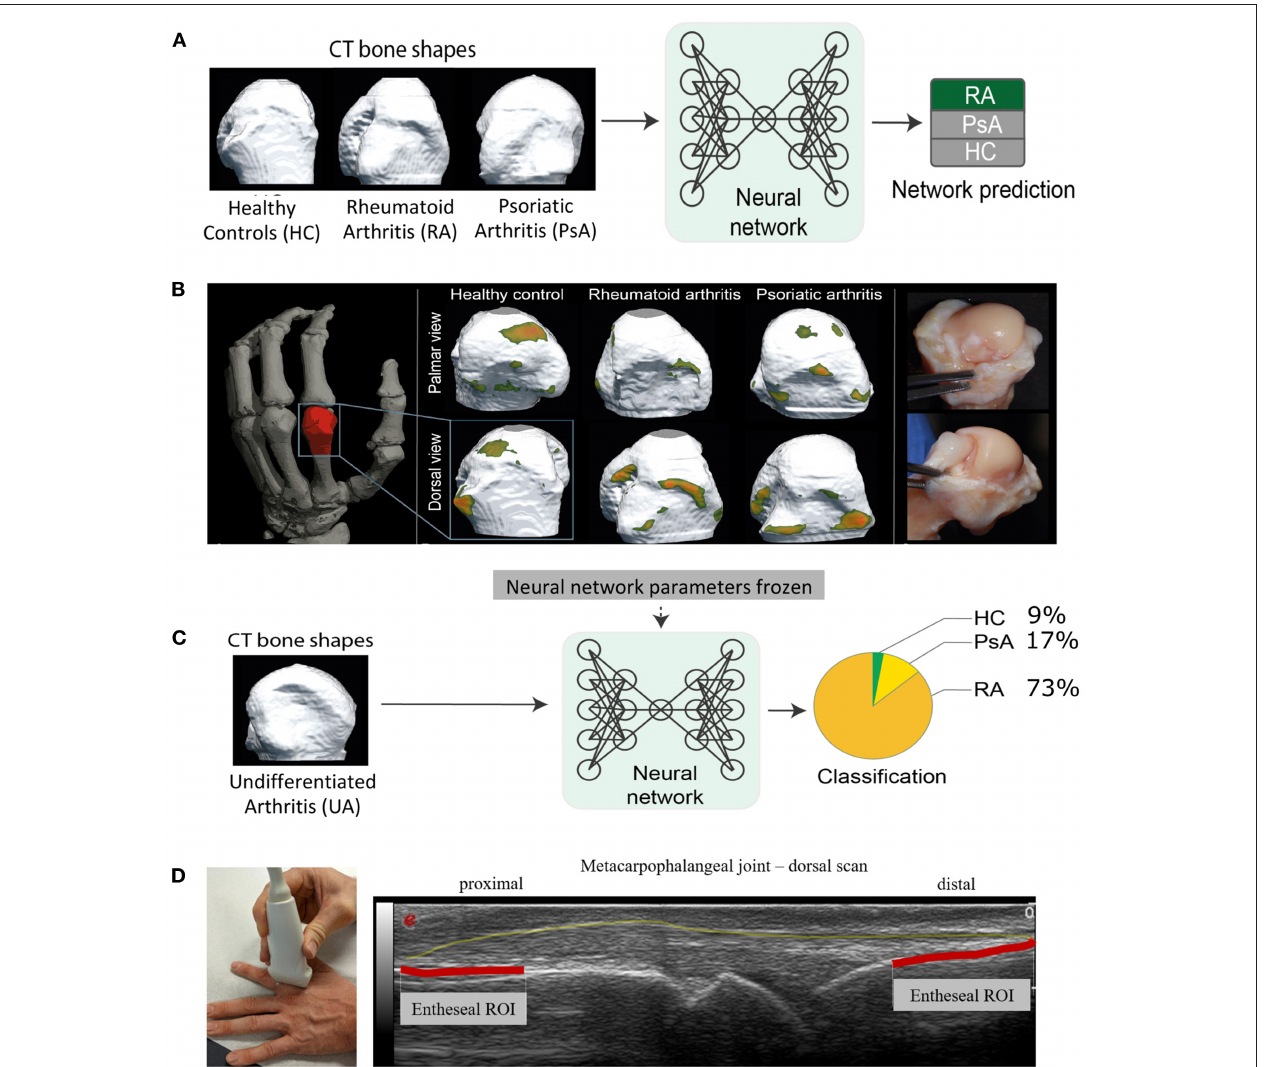
FIGURE 2 | Training and validation of the neural network, visualization of the regions influencing the networks decisions and application of network to undetermined arthritis cases. (A) Training and validation of the neural network using the three-dimesional articular bone shape (assessed by high-resolution peripheral computed tomography) of defined conditions such as rheumatoid arthritis (RA), psoriatic arthritis (PsA), and healthy controls (HC). (B) Left: Location of the measurement region (red) of high-resolution peripheral computed tomography (CT) scans as data source; center: Three different segmentation bone masks with the respective heat maps from healthy controls as well as RA patients and PsA patients; each patient segmentation mask is shown in the palmar view (top row) and in the dorsal view (bottom row); right: Preparation of anatomical specimen to correlate to heat maps detected by the neural network with anatomical regions. (C) Application of the neural network using undifferentiated arthritis patients to classify them into either RA, PsA, and HC according to the neural network defined in (A) . (D) Ultrasound image, dorsal scan of a healthy metacarpophalangeal joint. Here, we illustrate the transfer of our findings to arthrosonography. The outline of the capsule is marked yellow. The articular entheseal regions are marked in red. Based on the findings of the neural network, alterations of these articular entheseal regions (red) are specific for PsA and should be paid attention in clinical routine, especially in patients who are suspected for PsA. Patients provided written consent to the depiction of their